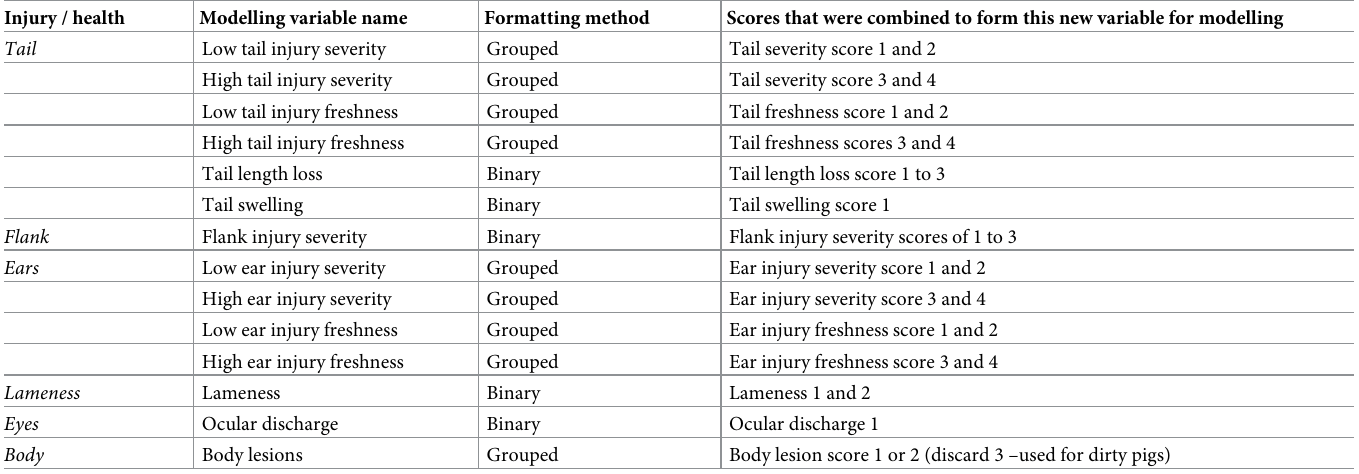
Table 2. Summary of how scores were combined to generate variables used in modelling.